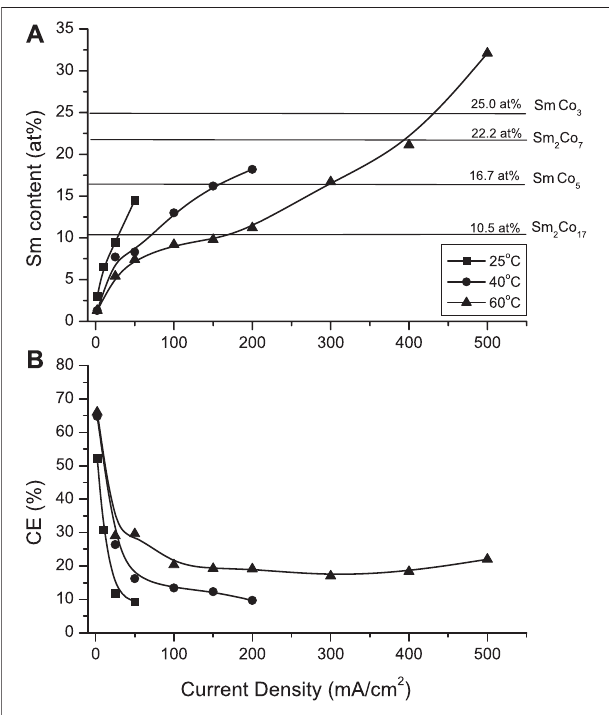
FIGURE 1 | Effect of current density and solution temperature on (A) deposit samarium content and (B) current ef fi ciency (CE).